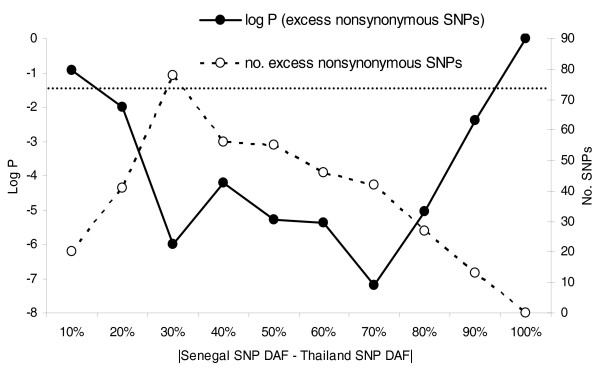
Significance and count of excess nonsynonymous SNPs segregating at various disparities in frequency between Senegal and Thailand. Statistical significance was evaluated in relation to synonymous SNP counts using Fisher's exact test. Horizontal dotted line indicates a P-value threshold of 0.05.